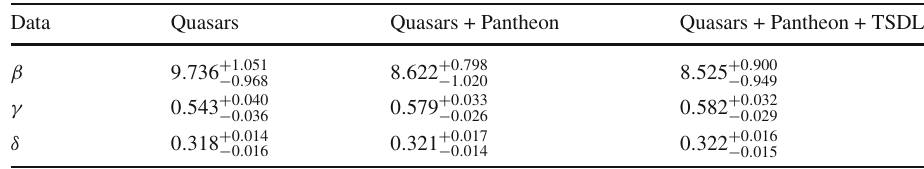
level constraints on the parameters β , γ , and δ in the Finslerian cosmological model with the 2015 quasar compilation and other datasets